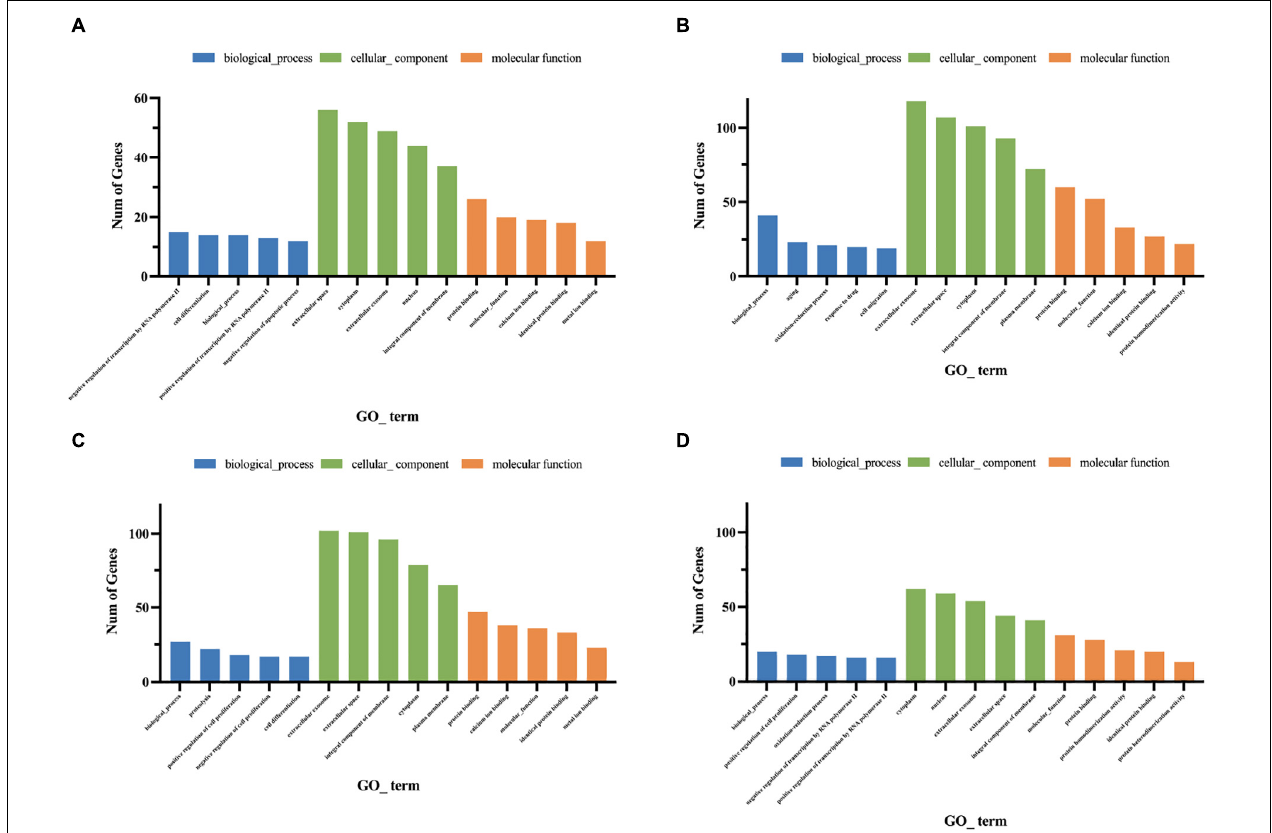
FIGURE 10 | Gene ontology enrichment analysis of genes for cluster 2 (A) , cluster 7 (B) , cluster 9 (C) , cluster 12 (D) . The Go functions include molecular functions, cellular components, and biological processes. The x-axis is the item of go function, and the ordinate represents the enriched genes by each